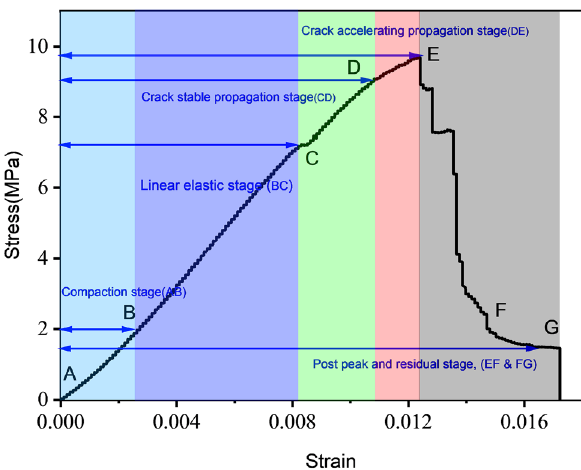
Figure 4. The coal’s sample stress–strain